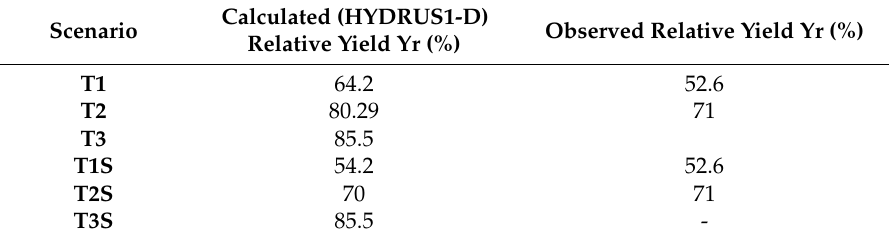
Table 6. Estimated versus observed yields for different treatments.